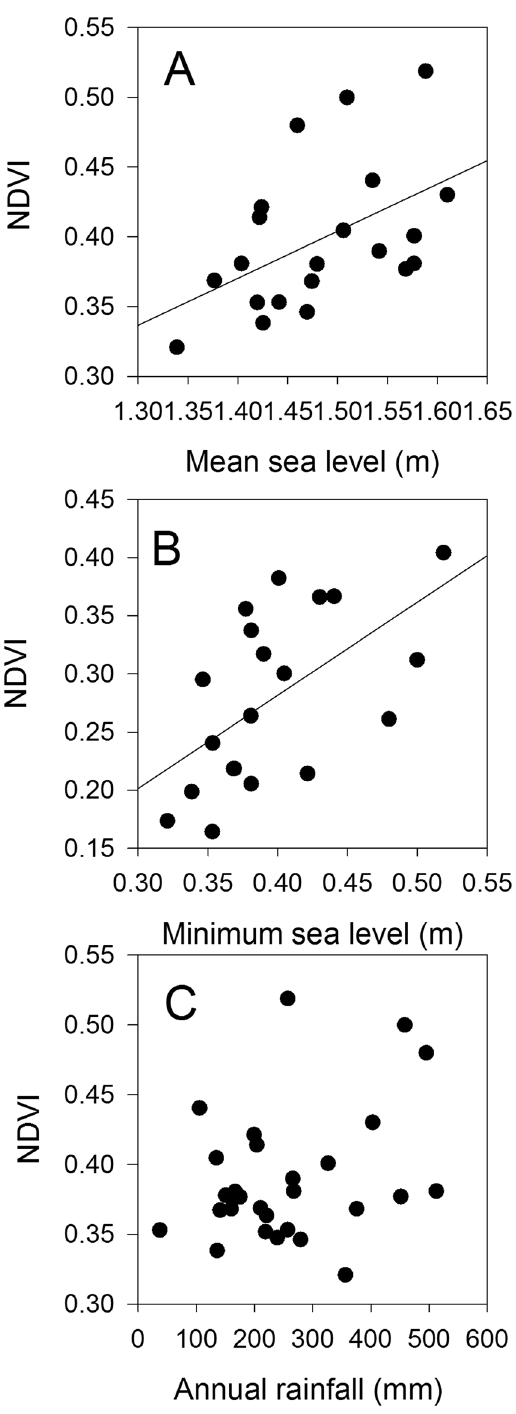
Figure 4. The annual mean Normalized Difference Vegetation Index (NDVI) of Mangrove Bay mangrove forest as a function of annual mean sea level ( A ), annual monthly minimum sea level ( B ) and annual rainfall ( C ). The regression line in panel A is y = − 0.10 + 0.336 * x, R 2 = 0.24 (P = 0.0246) and in panel B is y = 0.28 + 0.42 * x, R 2 = 0.34 (P = 0.0074). The relationship between annual NDVI and rainfall was not significant (P >